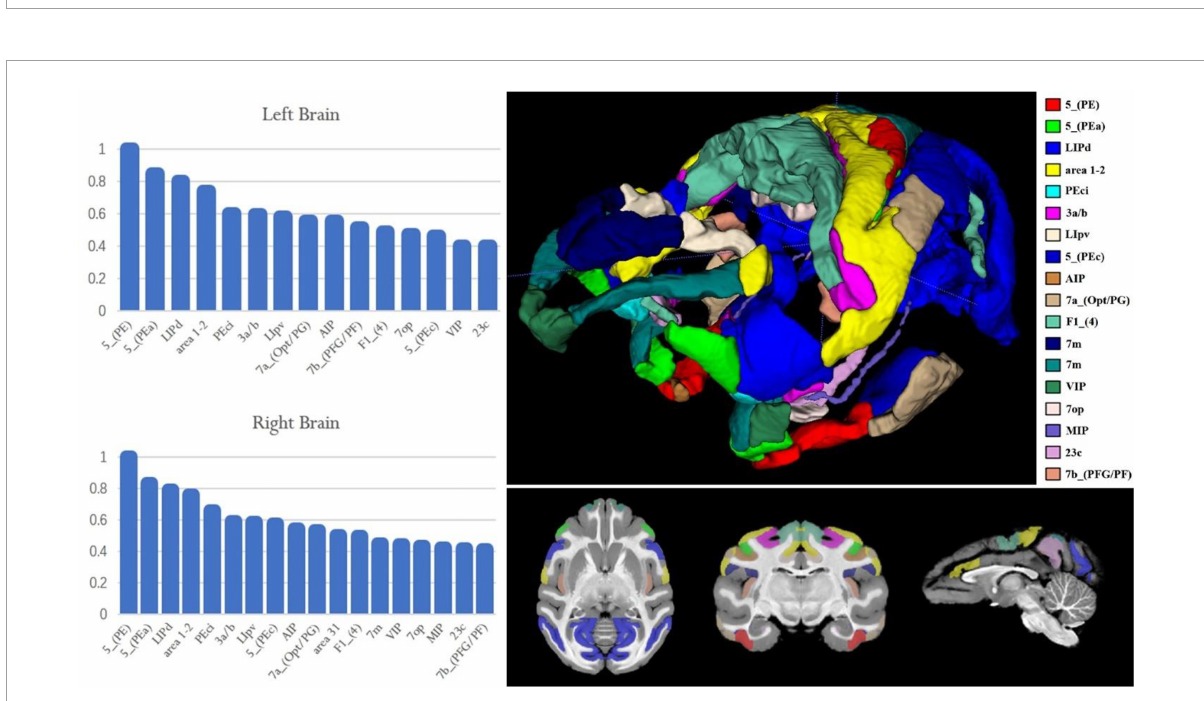
FIGURE8 Resting-state functional connectivity of the macaque PE area. The X-axis represents the region of interest used to calculate the connection; the Y-axis represents the value of the Pearson correlation coefficient. The upper left histogram represents the Pearson correlation coefficient between the PE region in the left hemisphere and the region of interest. The lower left histogram represents the Pearson correlation coefficient between the PE region in the right hemisphere and the region of interest. The image on the right shows the ROI region and its spatial location used on the left